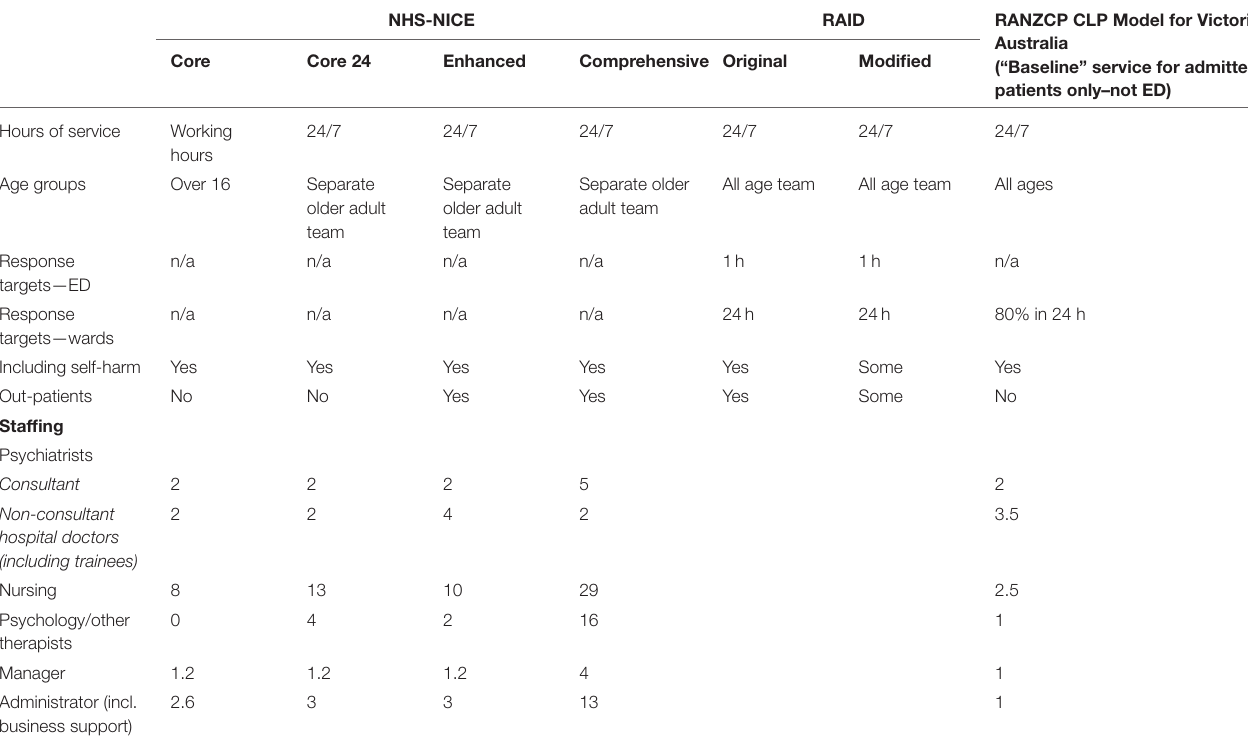
TABLE 1 | Comparison of different models of Consultation Liaison Psychiatry provision—NHS-NICE, RAID & RANZCP CLP Model for Victoria,